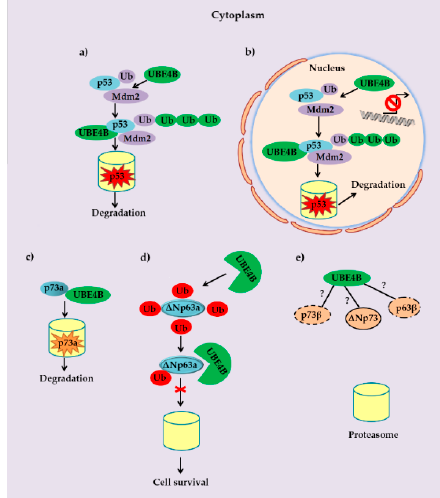
Figure 2. Interactions between UBE4B and p53 family members. ( a,b ) Turnover of p53 is regulated by both the MDM2 and the U-box type E3 / E4 ubiquitin ligase UBE4B. Mono-ubiquitination or mono-ubiquitination of p53 at multiple MDM2 sites is usually followed by a poly-ubiquitination of these sites mediated by UBE4B. The elongated ubiquitin chain targets the modified p53 molecule to the proteasome. This sequel occurs both in the cytoplasm and the nucleus, reducing not only the protein levels of p53 but also its transcriptional activity. ( c ) Ectopically expressed UBE4B ligase in various cancer cell lines interacts physically with p73a isoform and hinders the tumor-suppressor activity of the latter by promoting its proteasomal degradation in an ubiquitination-independent manner. ( d ) Evidence regarding UBE4B’s tumorigenic role has been reported in head and neck along with lung cancer cell lines. It appears that UBE4B protects ∆ Np63a from ubiquitination, resulting in its stabilization. ( e ) The potential role of UBE4B on regulating other p53 family isoforms such as p73 β , ∆ Np73 and p63 β is unknown and merits